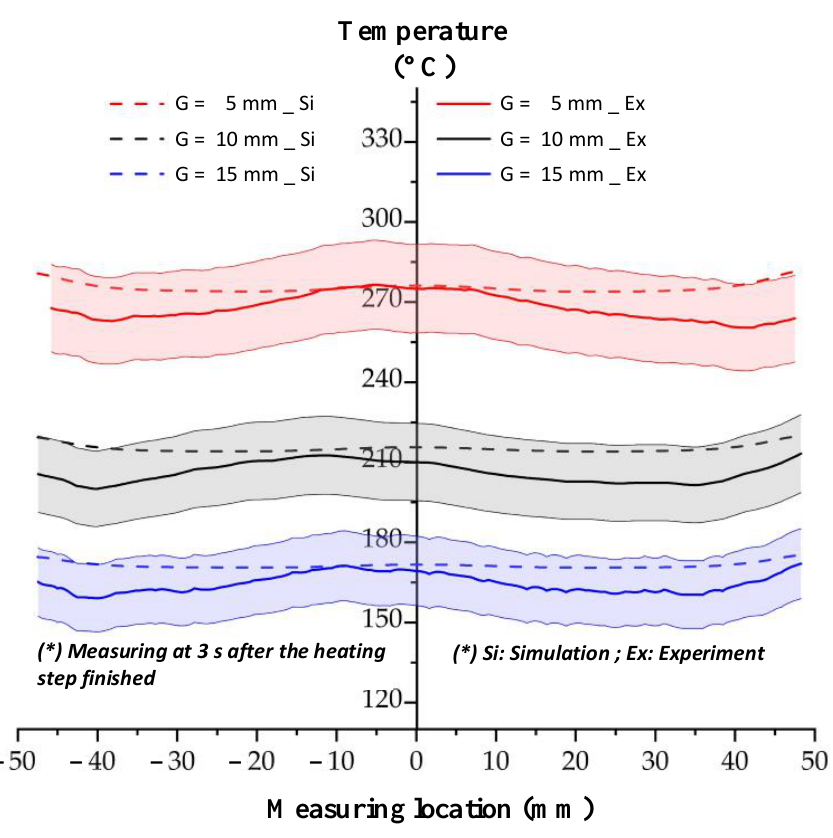
Figure 12. Comparing the temperature distribution of line L between simulation and experiment with the heating time of 5 s.